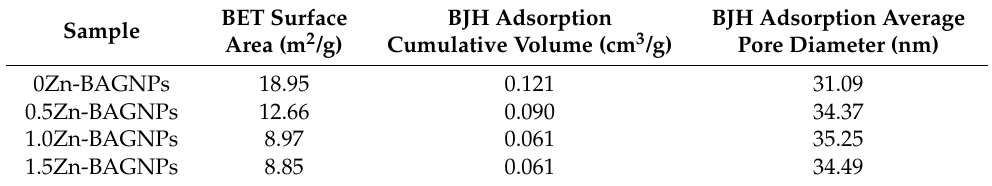
Table 5. Textural